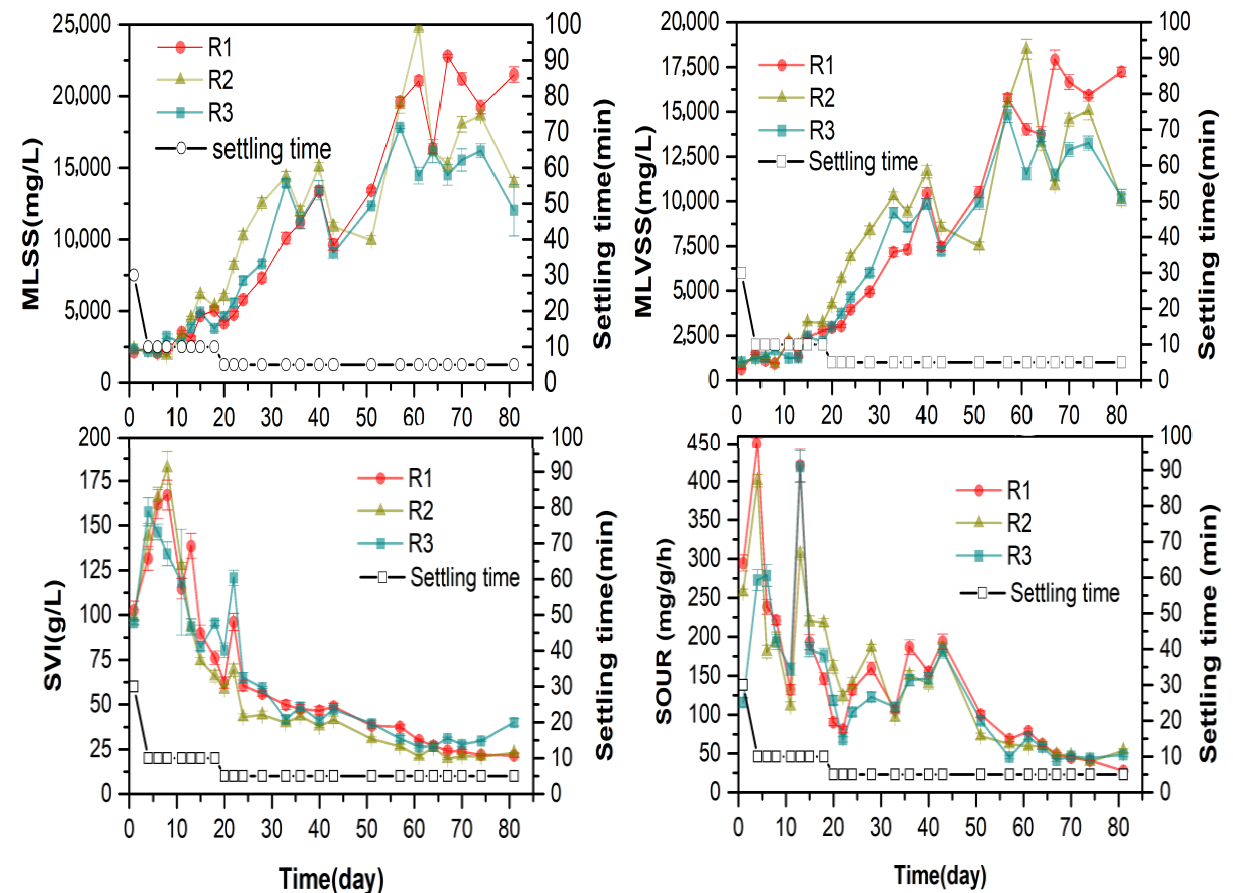
Figure 2. The variations in MLSS, MLVSS, settleability (SVI), and microbial activity (SOUR) during aerobic granules’ formation process in R1, R2, and R3. aerobic granules’ formation process in R1, R2, and